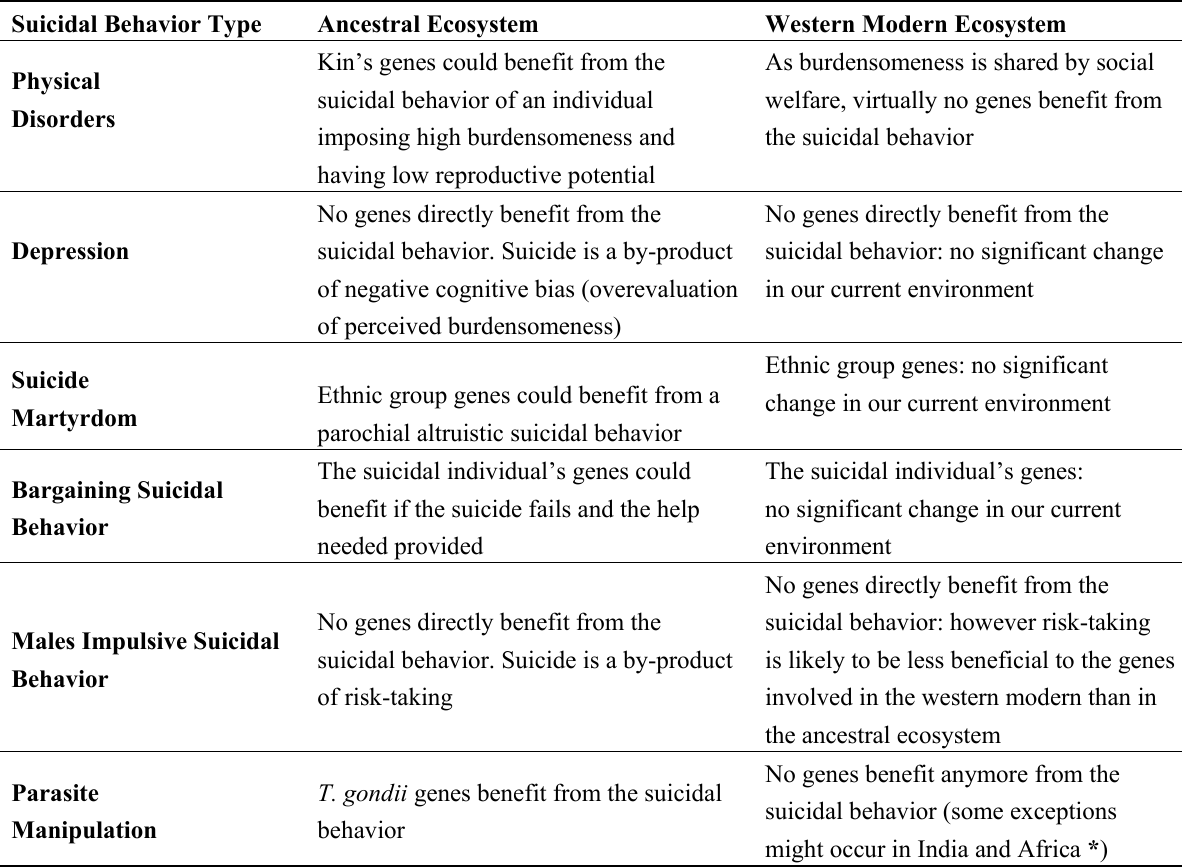
Table 1. Whose genes may benefit from the suicidal